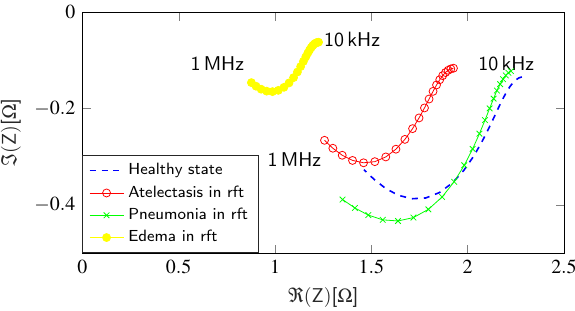
(c) Simulated impedance spectrum for different pathologies in the inhaled state. The measurements are focused on the rft region. In blue, the healthy state is shown. Atelectasis is simulated in red, pneumonia in green and edema in yellow. Fig.6: Simulation results for an impedance measurement focused on the right, front, top region of the